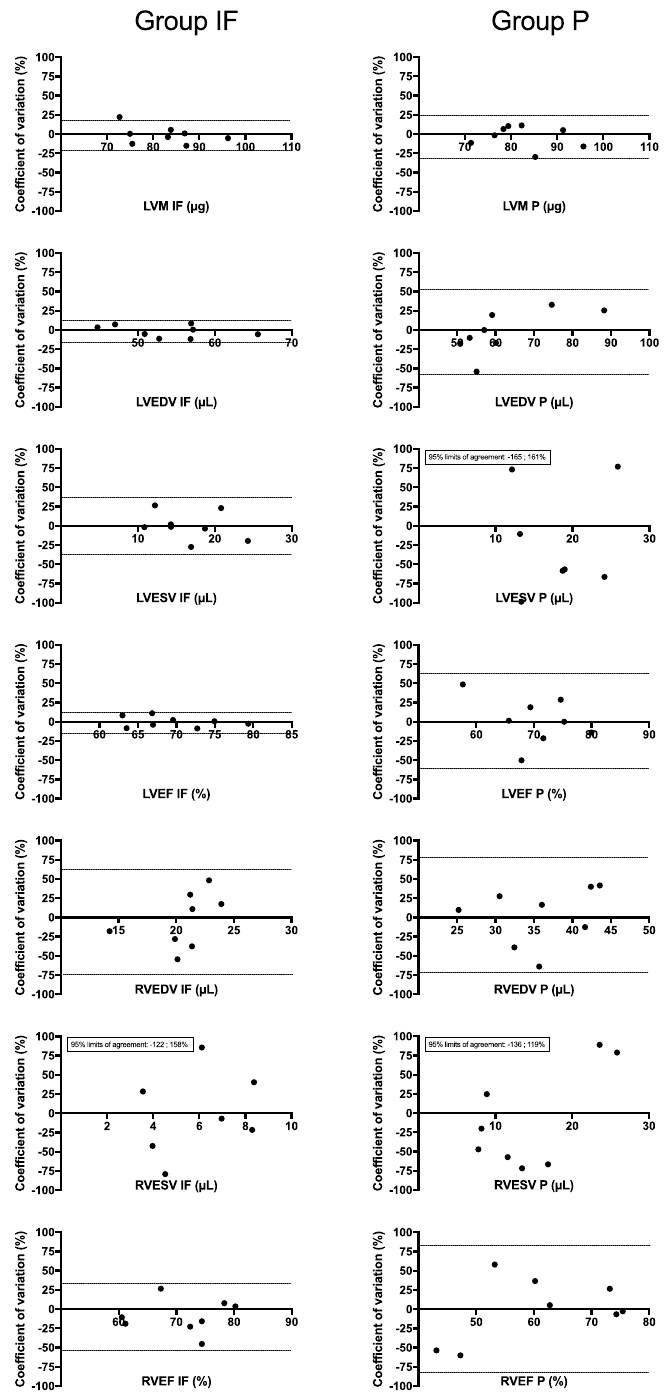
Figure 2. Bland-Altman representation of inter-study differences. Mean CMR1/CMR2 values on the X-axis are plotted against the coefficient of variation (COV) between CMR1 and CMR2 on the Y-axis for groups IF (isoflurane) (left column) and P (pentobarbital) (right column). The 95% limits of agreement are represented on each graph by thin dotted lines (or printed values when out of the graph